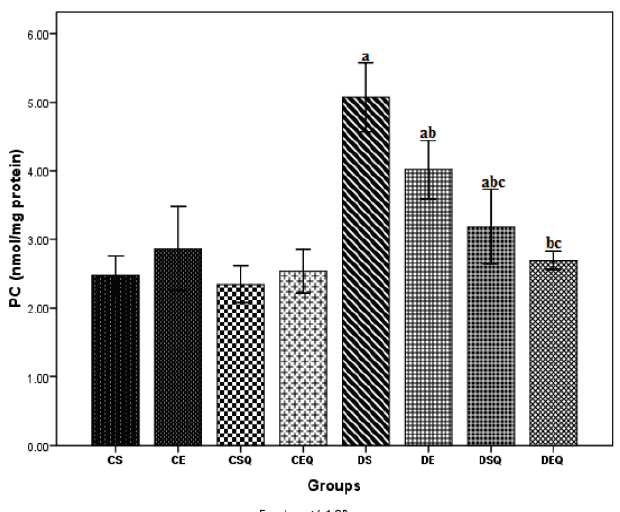
Figure 2. The effects of quercetin and moderate exercise training on protein carbonyl groups (PC) (nmol/mg protein) in the thoracic aortic tissue homogenates of control and diabetic rats. Results are the means ± SD for ten animals each group defined as in the caption of Figure 1. Statistically significant differences are indicated by the symbols: a p < 0.05 vs. CS group, b p < 0.05 vs. DS group and c p < 0.05 vs. DE group.